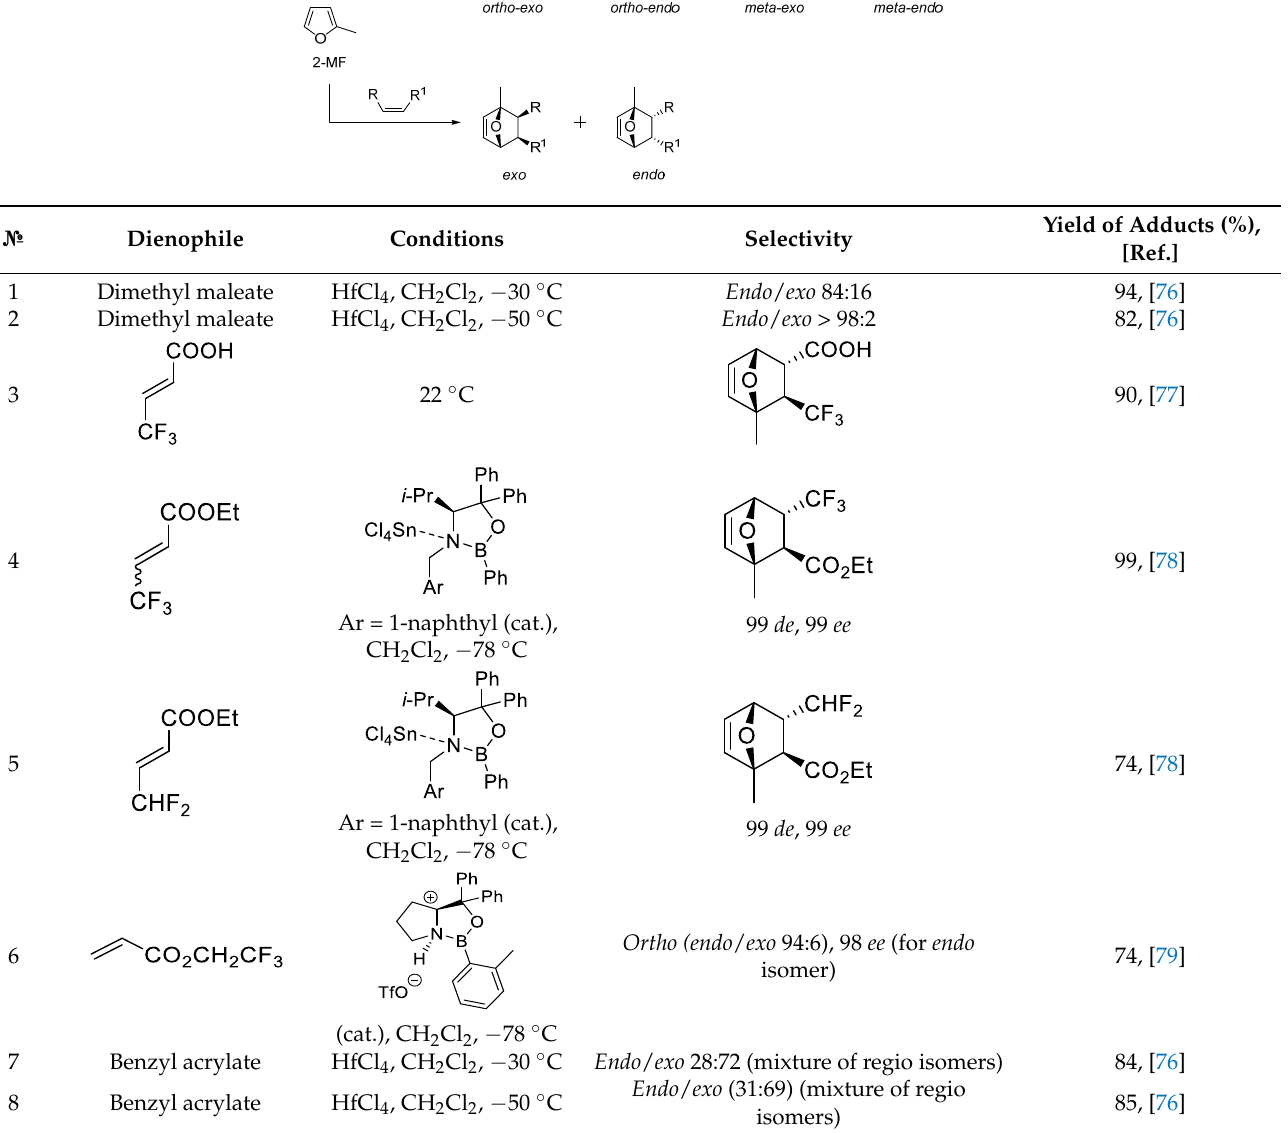
Table 2. IMDA cycloadditions of 2-MF with acyclic alkenes.